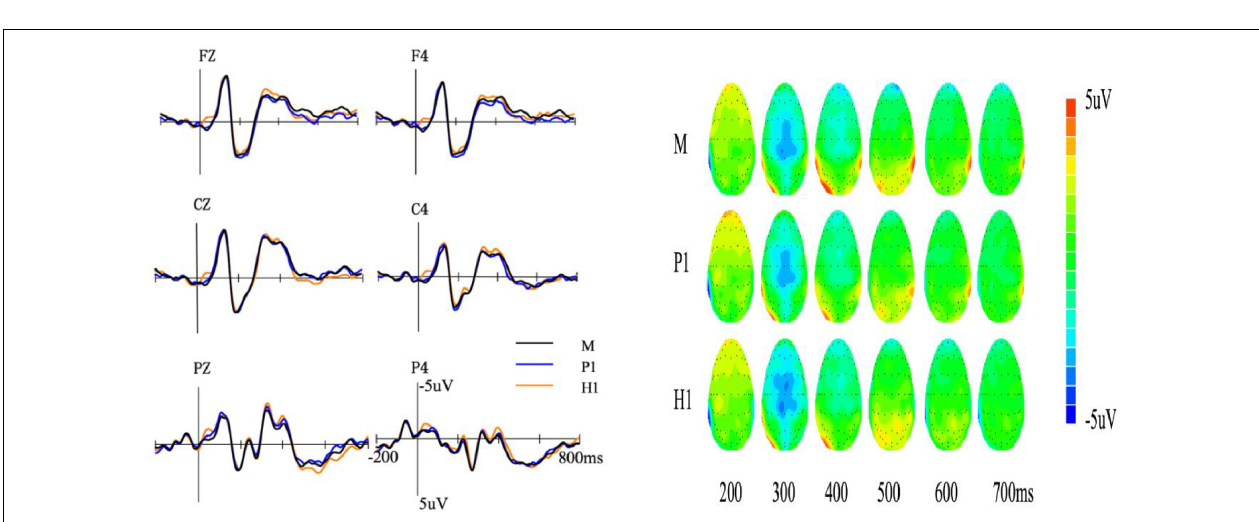
FIGURE 3 | Event-related potentials (left) and topography (right) of the three meaning types in session B. M, monosomies; P1, the first meaning of polysemy; P2, the second meaning of polysemy; H1, the first meaning of homonym; H2, the second meaning of homonym.